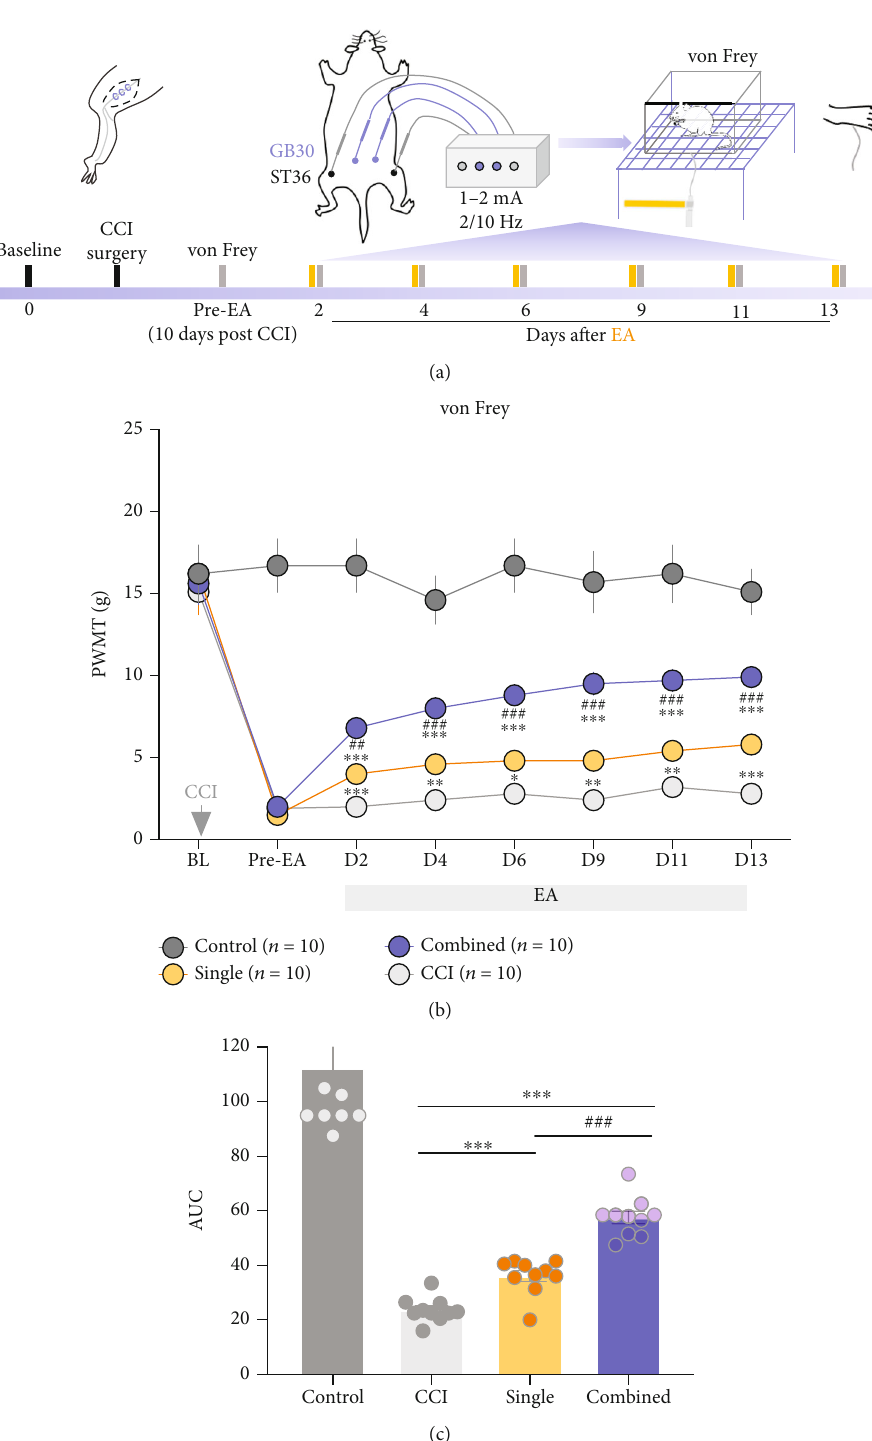
Figure 1: Combined-acupoint EA was more e ff ective than single-acupoint EA in inducing the analgesic e ff ects in CCI rats. (a) Schematic (top) and timeline (bottom) of the CCI model, pain behavior tests (von Frey), and EA stimulation. (b) Time course of CCI injury elicited remarkable mechanical allodynia in the CCI group. Both single-acupoint and combined-acupoint EA alleviated pain, as the paw withdrawal threshold was consistently decreased. The combined-acupoint EA exerted more e ff ective antinociception than single-acupoint EA, and the statistical di ff erence of analgesia between these two groups lasted from day 2 to day 13 of the EA treatment. Two-way ANOVA followed by Bonferroni ’ s multiple comparisons test. (c) Area under the curve of graph b (from “ BL ” to D13). Student ’ s unpaired t -test. All data are mean ± SEM , ∗ P < 0 : 05 , ∗∗ P < 0 : 01 , ∗∗∗ P < 0 : 001 vs. CCI; ## P < 0 : 01 , ### P < 0 : 001 vs. single, N = 10 in each group. BL: baseline; CCI: chronic constriction injury; EA: electroacupuncture; AUC: area under curve; PWMT: paw withdrawal mechanical threshold; vs: versus; orange column indicated the EA; gray column indicates the von Frey